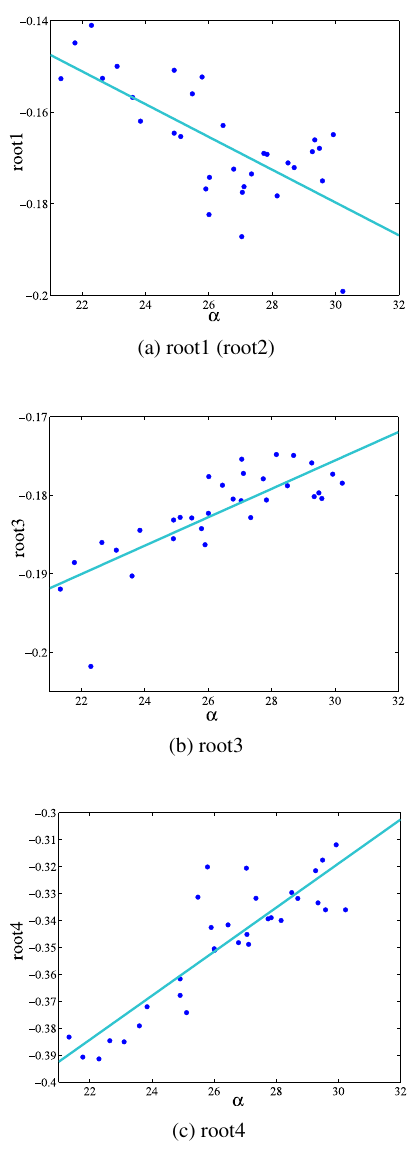
Fig. 6 Relationship between arch parameter α and real parts of roots (longitudinal)